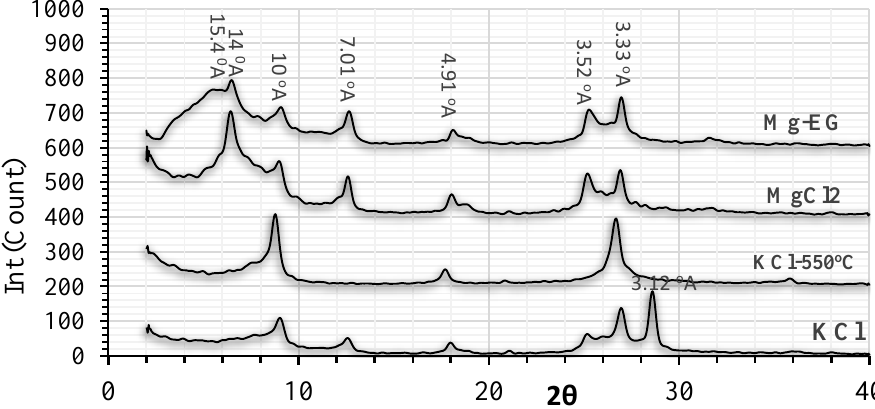
Figure 1. X-ray diffractograms of the clay soil collected from the Charmahal and Bakhtiari province for laboratory analysis.